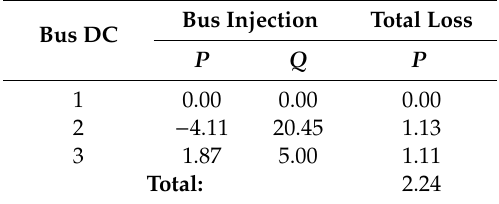
Table A24. Results of the mixed AC / DC PF calculations in Case 6-1. DC bus